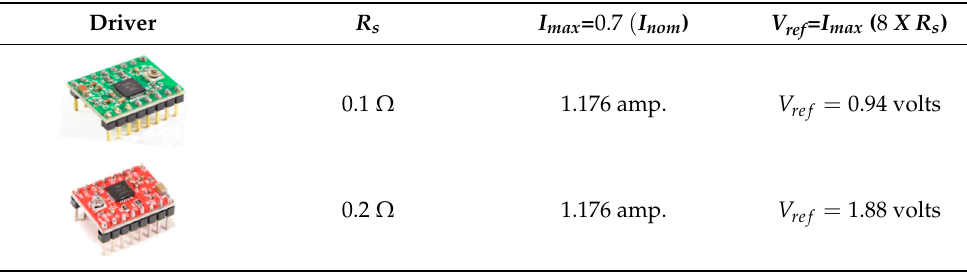
Figure 10. V ref setting values with R s = 0.2 ohms with respect to motor current. Table 5. V ref of the A4988 drivers.